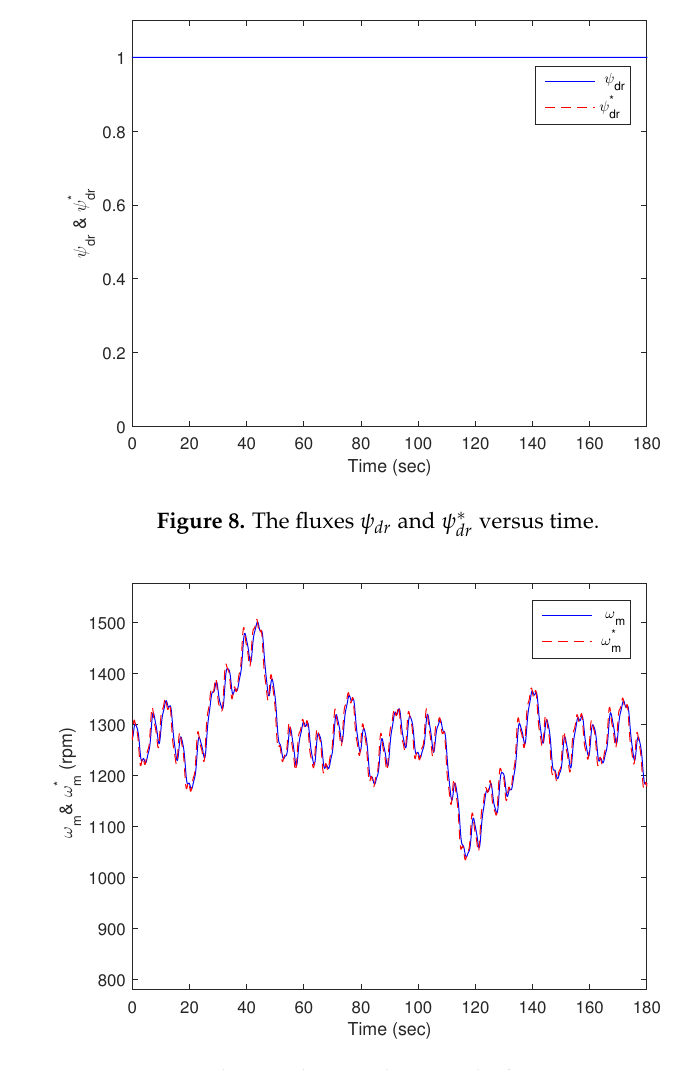
Figure 9. The angular speeds ω m and ω ∗ m versus time.